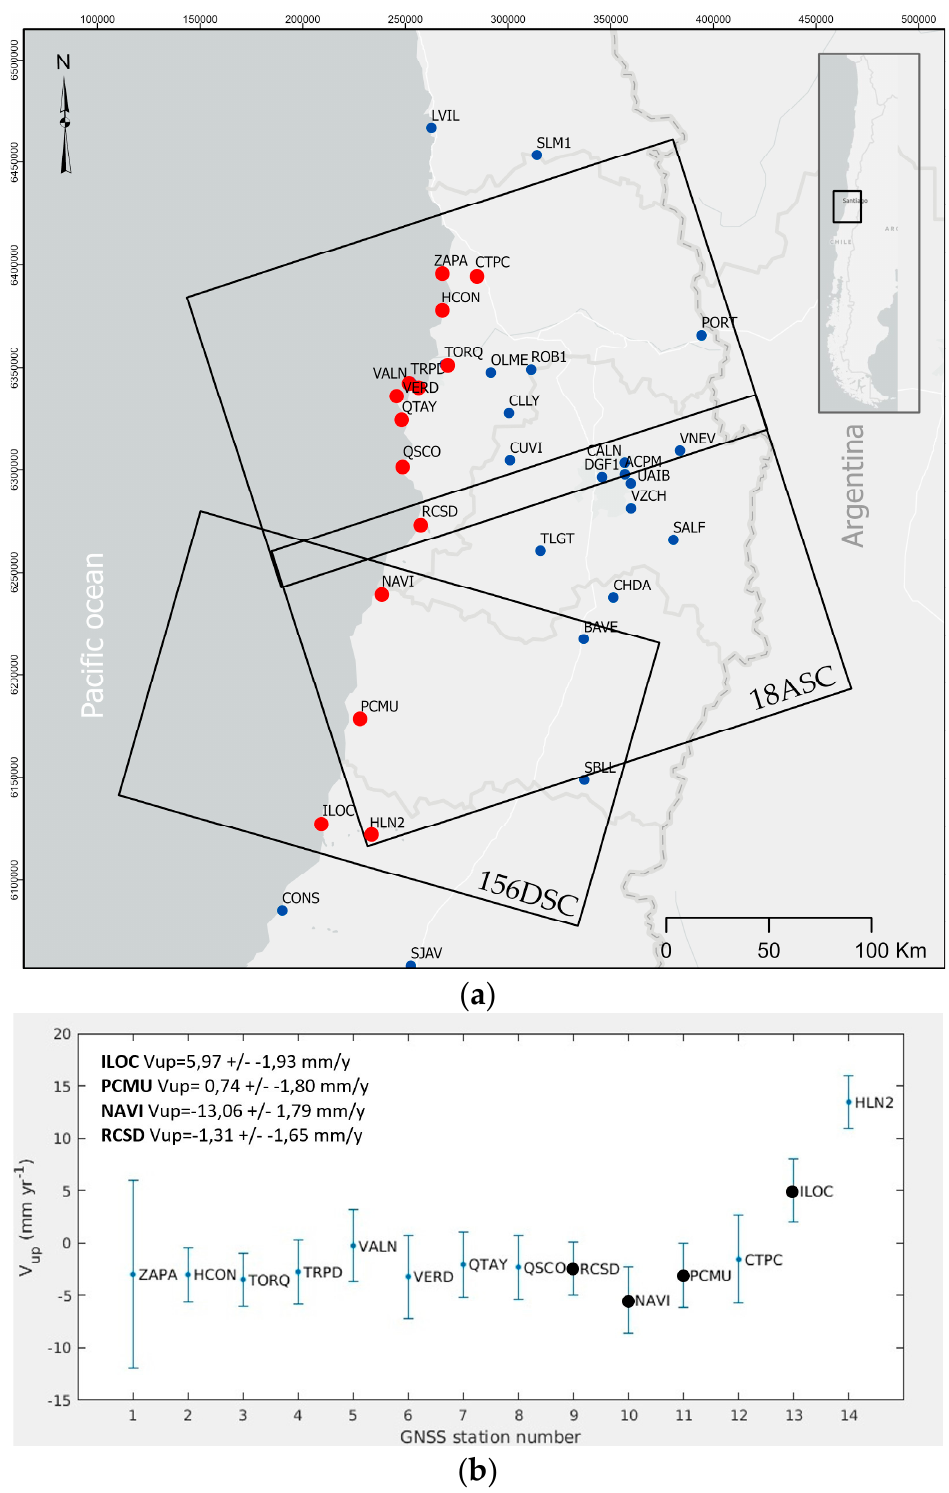
Figure 4. ( a ) Data set used, tracks Sentinel-1 along both relative orbits for ascending (18ASC) and for descending (156DSC), and coastline GPS (red points); ( b ) GPS plot data, with black points representing GPS selected for subsidence areas RCSD, NAVI, PCMU, and ILOC.